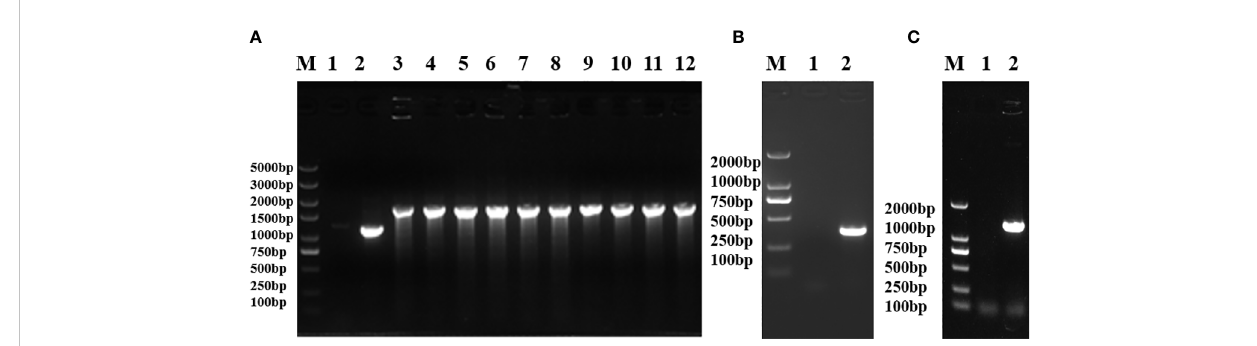
FIGURE 1 Identi fi cation of uridine diphosphate – glucose pyrophosphorylase galU gene mutants. (A) Replacement of the galU gene with the Kn resistance gene. Lane M, molecular mass markers; Lane 1, negative control; Lane 2, S584; Lane 3 − 12, S584 D galU -Kn. (B) Con fi rmation of galU mutation showing gene loss in S. typhimurium lacking a Kn resistance gene. Lane M, molecular mass markers; Lane 1, negative control; Lane 2, S584 D galU . (C) Identi fi cation of the complementation strain showing that the galU gene was successfully reintroduced after mutation. Lane M, molecular mass markers; Lane 1, negative control; Lane 2, S584 D galU